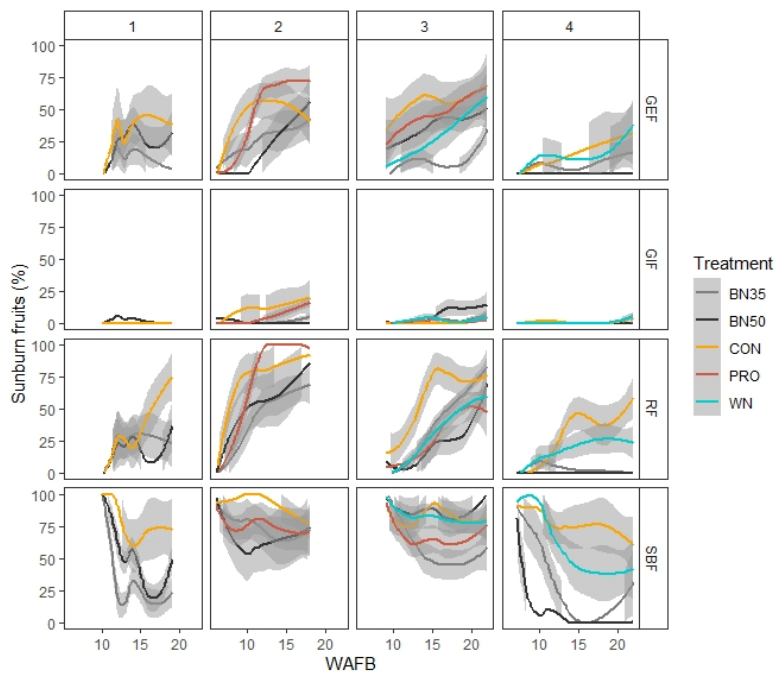
Figure 6. Evolution of the percentage of sunburned fruits by treatment (BN35 = Black net 35, BN50 = Black net 50, WN = White net, CON = control and PRO = protectants) according to weeks after full bloom (WAFB), fruit condition (RF = red fruit, GEF = green external fruit, GIF = green internal fruit, and SBF = sunburned fruit) and season (1 to 4). Lines and 0.95 confidence intervals were calculated according to geom_smooth function (loess method in R).